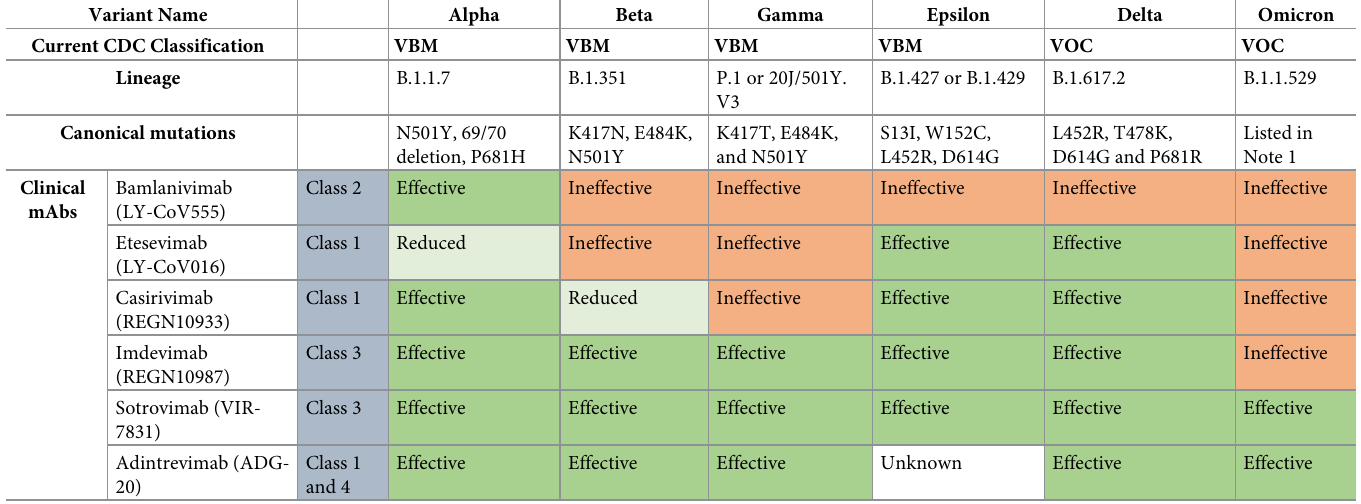
Table 1. Efficacy of clinical mAbs, lineages, and canonical mutations in SARS-CoV2 VOCs. REGN-CoV (REGN10987/Imdevimab and REGN10933/Casirivimab) by Regeneron, VIR-7832 and VIR-7831 (Sotrovimab) by GSK and Vir biotechnology, and LY-CoV555 (Bamlanivimab) and LY-CoV016 (Etesevimab) by Eli Lilly and Com- pany are some of the approved antibody cocktails for emergency use in mild-to-moderate COVID-19 patients. These antibodies were obtained from the people who got infected with SARS-CoV-2 during the first wave of the pandemic. These therapeutic antibody cocktails targeting noncompeting epitopes have varied degrees of neutraliz- ing efficacies against VOCs. The color of highlighted text represents the levels of efficacy mAb retains against each VOC: green represents the mAb retains efficacy; light- green represents reduced efficacy; and orange represents that the mAb is ineffective. ADG-20 developed by Adagio binds to an epitope located in between the Class 1 and Class 4